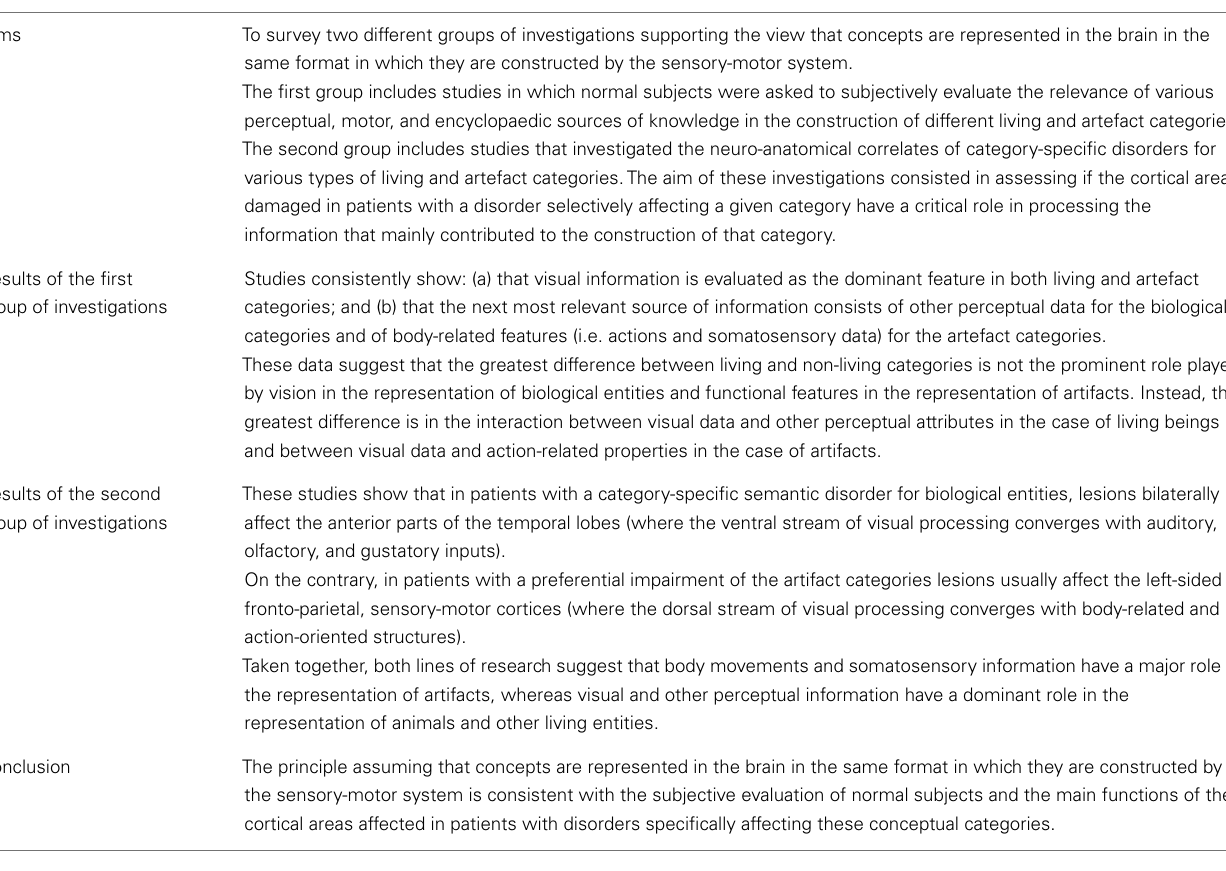
Table 1 | Overview of the main findings of the present